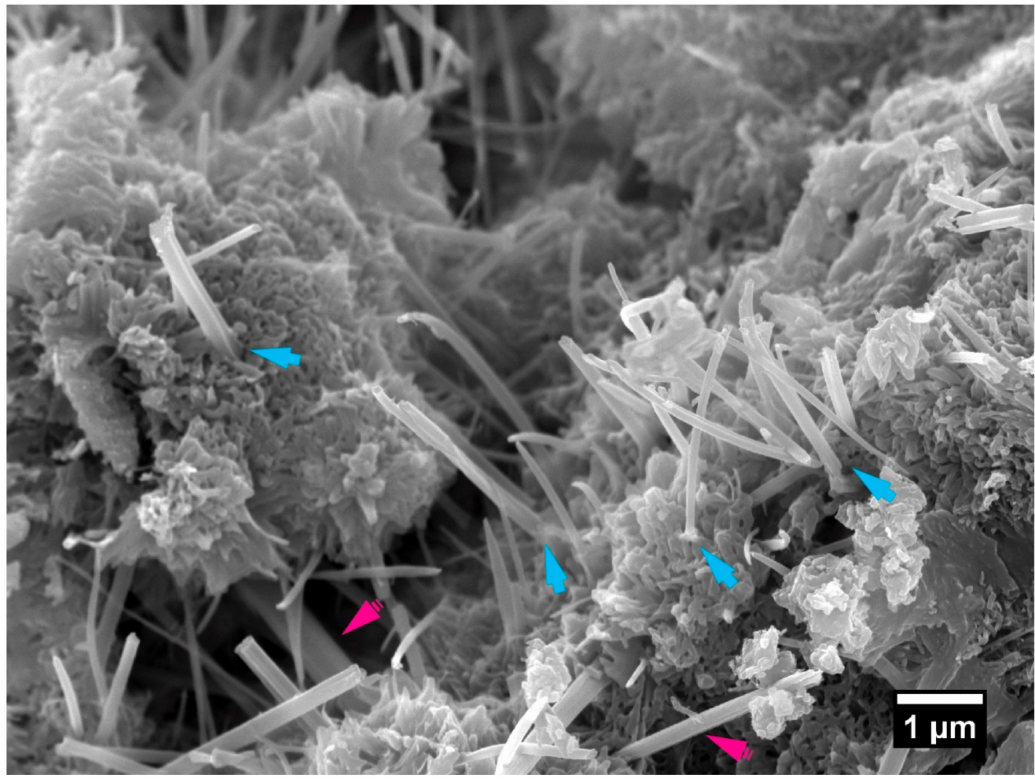
Figure 7. A secondary electron micrograph of fracture surface of specimen C 10 , 7 days, showing CNTs embedded within C-S-H formations (blue arrows) within the hydrated cementitious microstructure. Ettringite structures are indicated by magenta arrows. Table 4. Experimental water permeability coe ffi cients (K), with the 95% confidence interval widths in